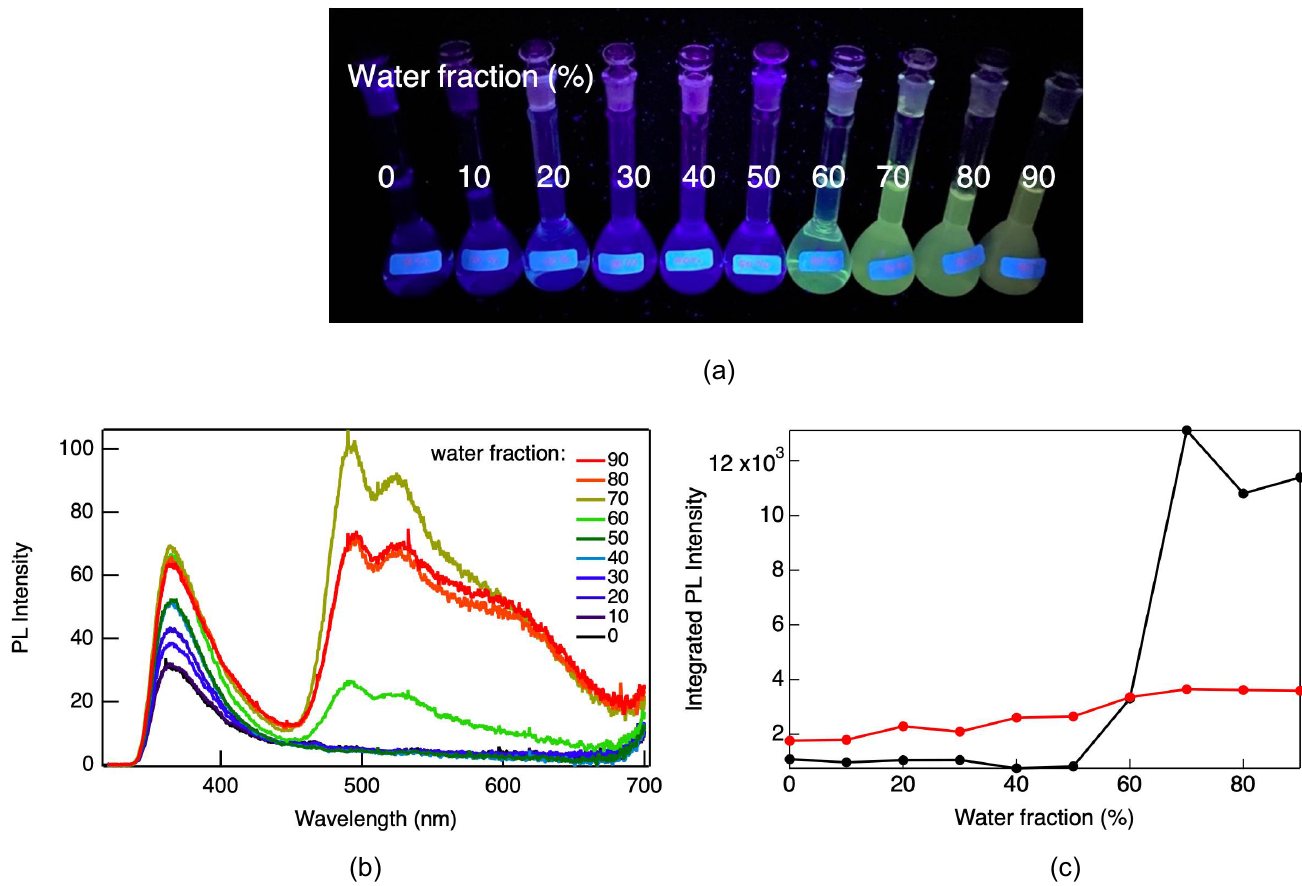
Figure 4. ( a ) Photograph of B2-5 in THF/water mixed solvent ( f w = 0–90%) under a 365 nm UV light, ( b ) Emission spectra of B2-5 in f w = 0–90% with a concentration of 1 × 10 − 4 mol L − 1 ( λ ex = 303 nm). ( c ) Integrated photoluminescence intensity in the range of 330–450 nm (red) and 450–700 nm (black) as a function of f w .